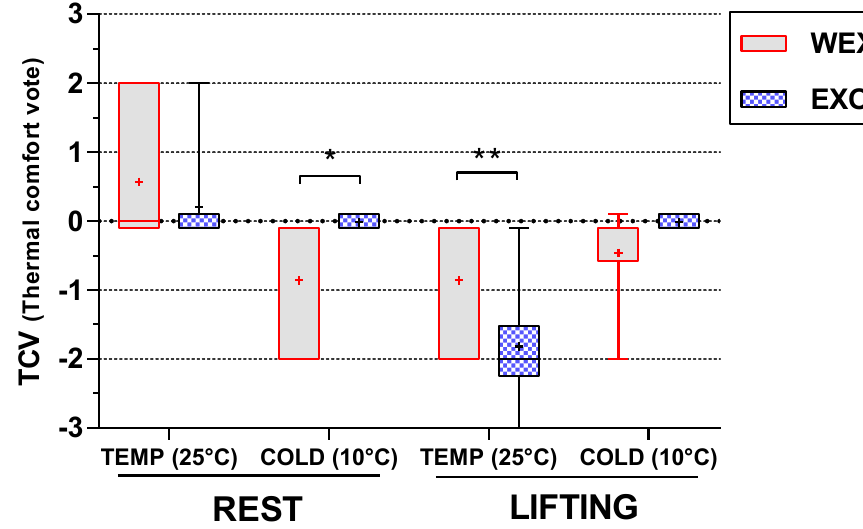
Figure 8. Thermal comfort vote in steady − state condition (* p < 0.05, ** p < 0.01).